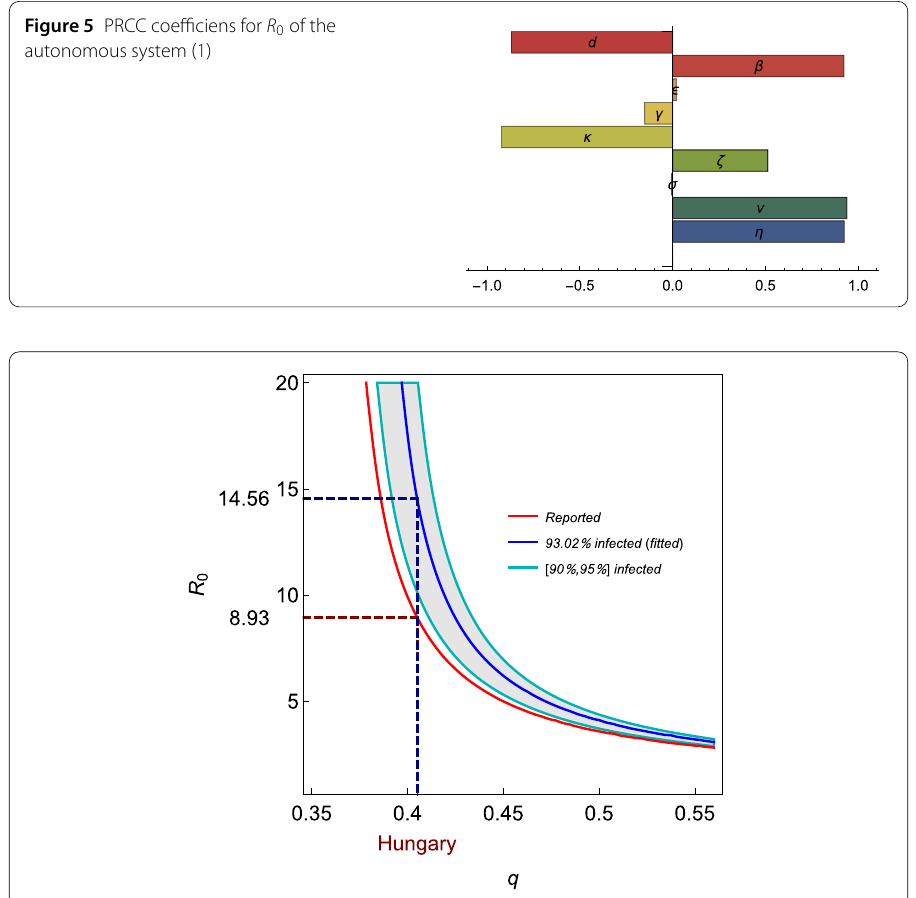
Figure 6 Relation between the underreporting ratio q and the basic reproduction